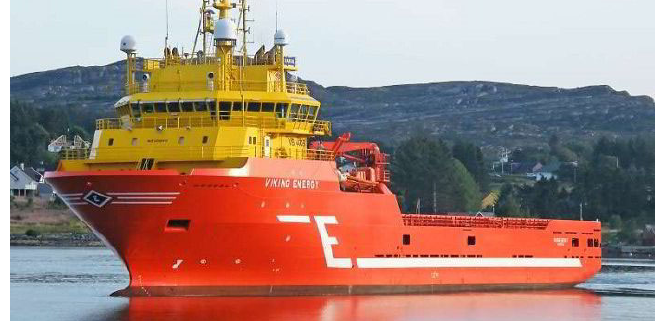
Figure 13. In the ammonia cracker, ammonia is separated into nitrogen and hydrogen. It is then later used to generate power in the fuel cell. No hazardous nitrogen oxides are created thanks to the catalytic converter. Water and nitrogen are the only end products [112].